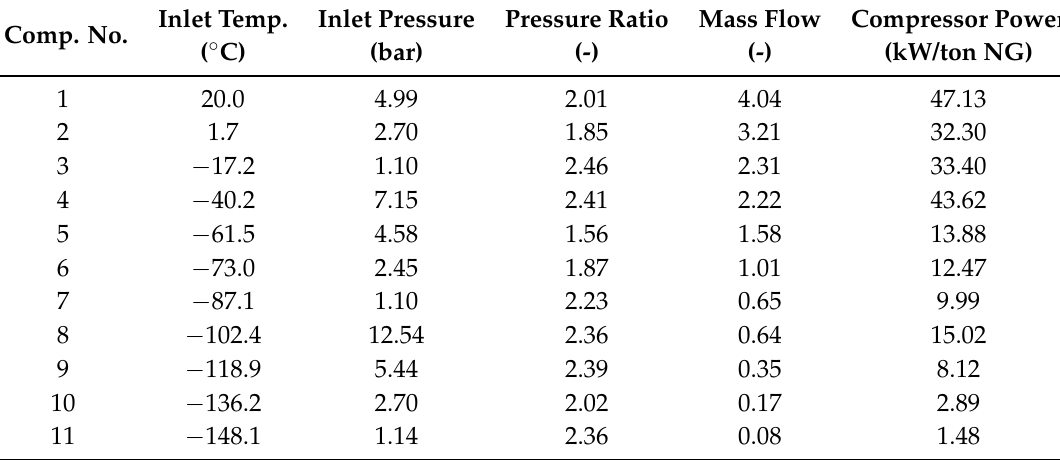
Table 4. Process parameters for the optimized 3-4-4-Cascade. Mass Flow is defined as ˙ m / ˙ m NG . Comp.